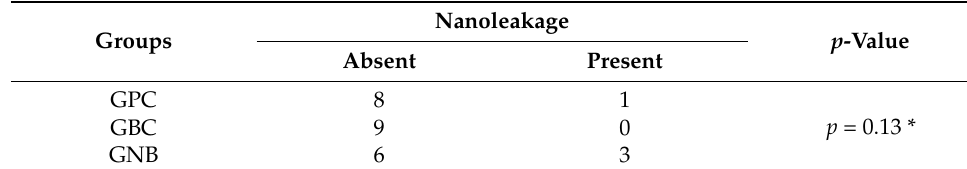
Table 1. Distribution of the presence of nanoleakage by lanthanum in the GPC (conventional gutta percha), GBC (BC Sealer gutta percha), and GNB (niobium phosphate gutta percha) groups.